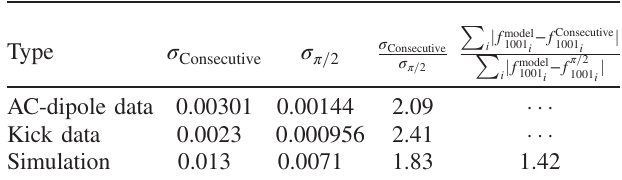
TABLE I. A comparison of the two different BPM paring algorithms. σ is the average error bar for BPM pairs with Consecutive consecutive BPM, σ π = 2 is the average error bar for BPM pairs with phase advance close to π = 2 , f model 1001 is the f 1001 reconstructed from the model, f π = 2 1001 is the reconstructed f 1001 from BPM pairs with a phase advance close to π = 2 and f Consecutive 1001 from BPM pairs with consecutive